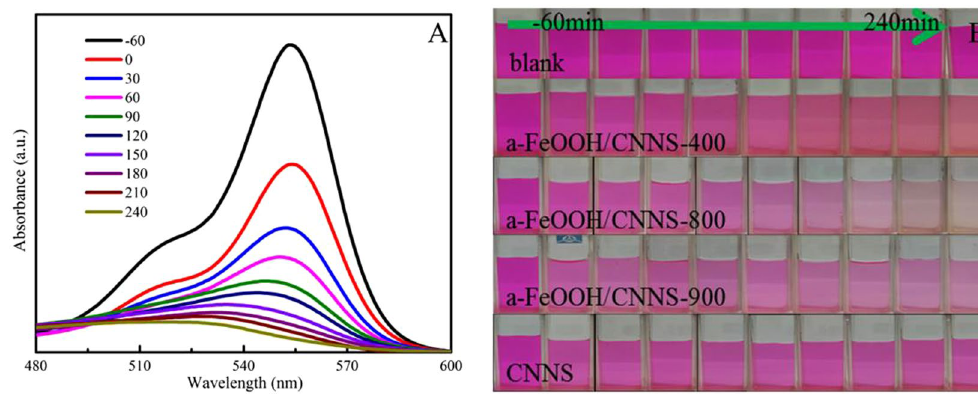
Figure 10. ( A ) The absorption spectra of RhB degraded by a-FeOOH/CNNS-800 composite under visible light irradiation; ( B ) The corresponding digital photograph of RhB degraded by a-FeOOH/CNNS composites under visible light